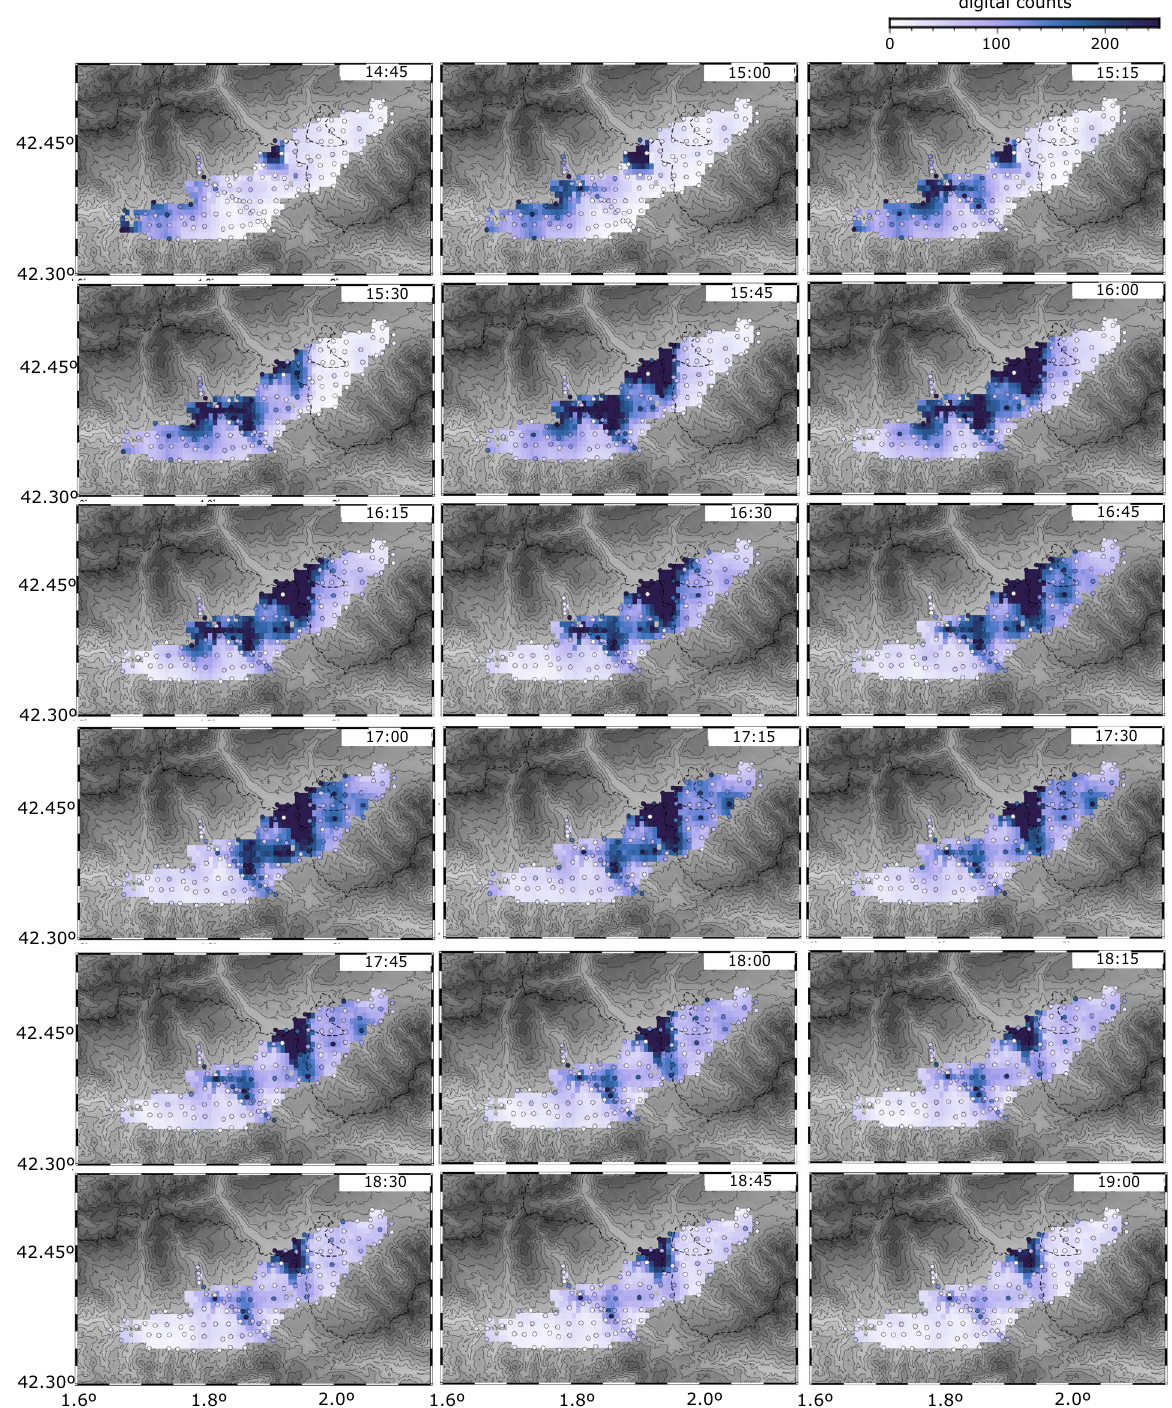
Figure 4. Snapshots of seismic noise maps during the 26 April rainfall episode. Each image shows the mean amplitude of the vertical seismic component for 15 min intervals for frequencies above 40 Hz. Dark colors represent large amplitude values and are interpreted to relate to rainfall. A grey color palette indicates topography (see Fig.